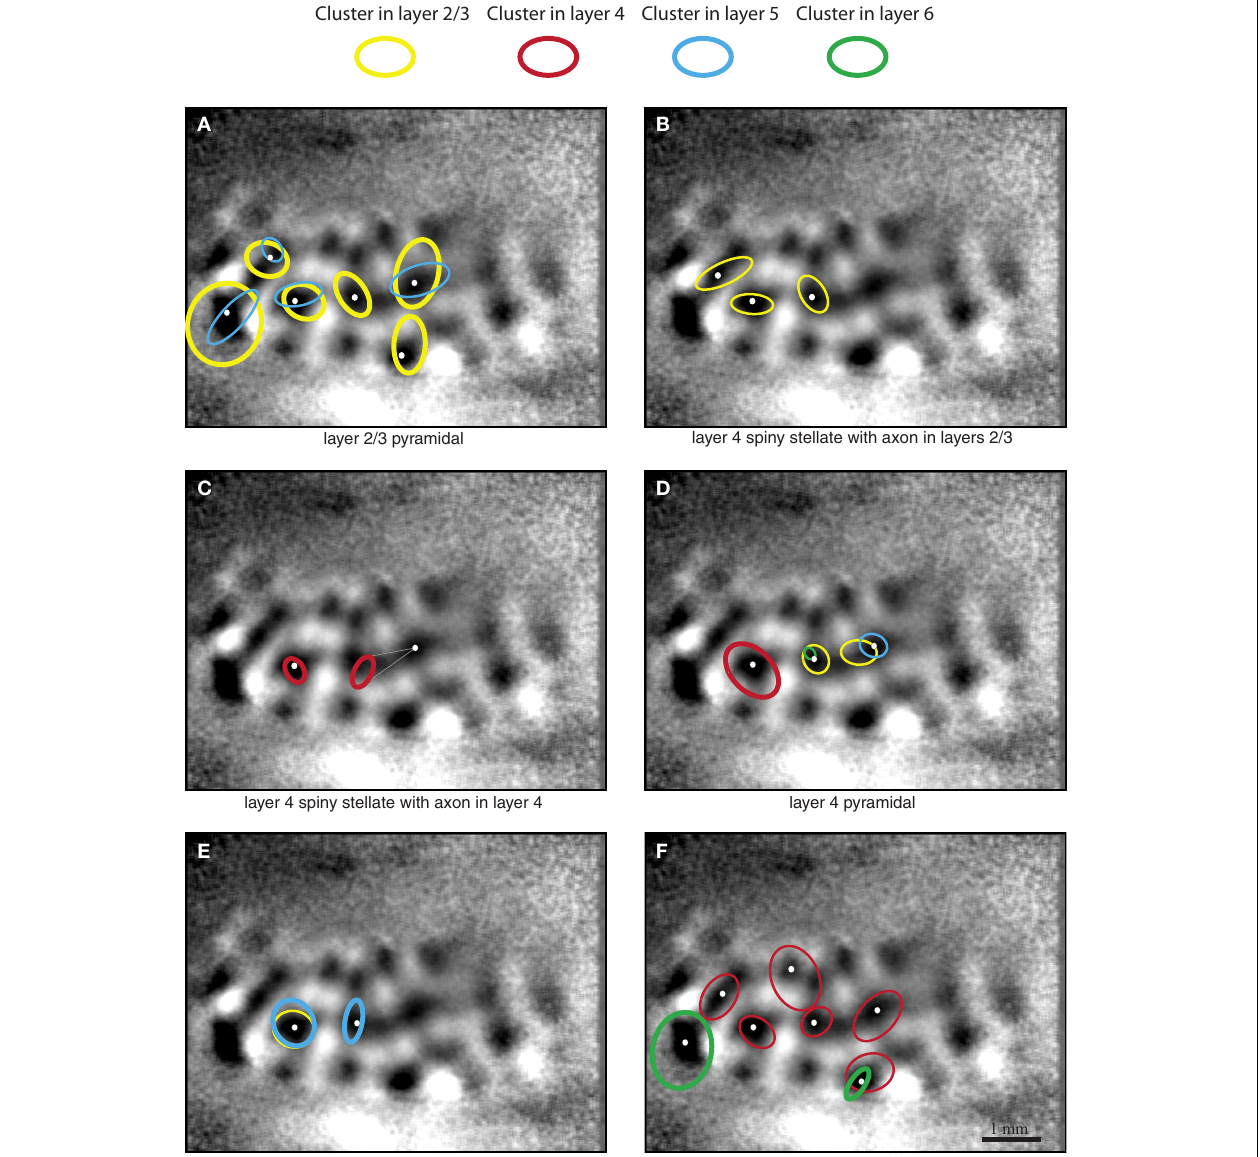
FIGURE 2 | Comparison of the size of the proximal cluster of boutons and functional domains for a single orientation recorded with optical imaging. Proximal clusters formed by neurons of layer 2, 3 and 6 are often larger than the orientation domains. Also apparent is the fact that the size of the proximal clusters varies between different neuronal types. (A–F) Show proximal clusters of different neurons (the cell bodies are shown as white dots) from a single cell